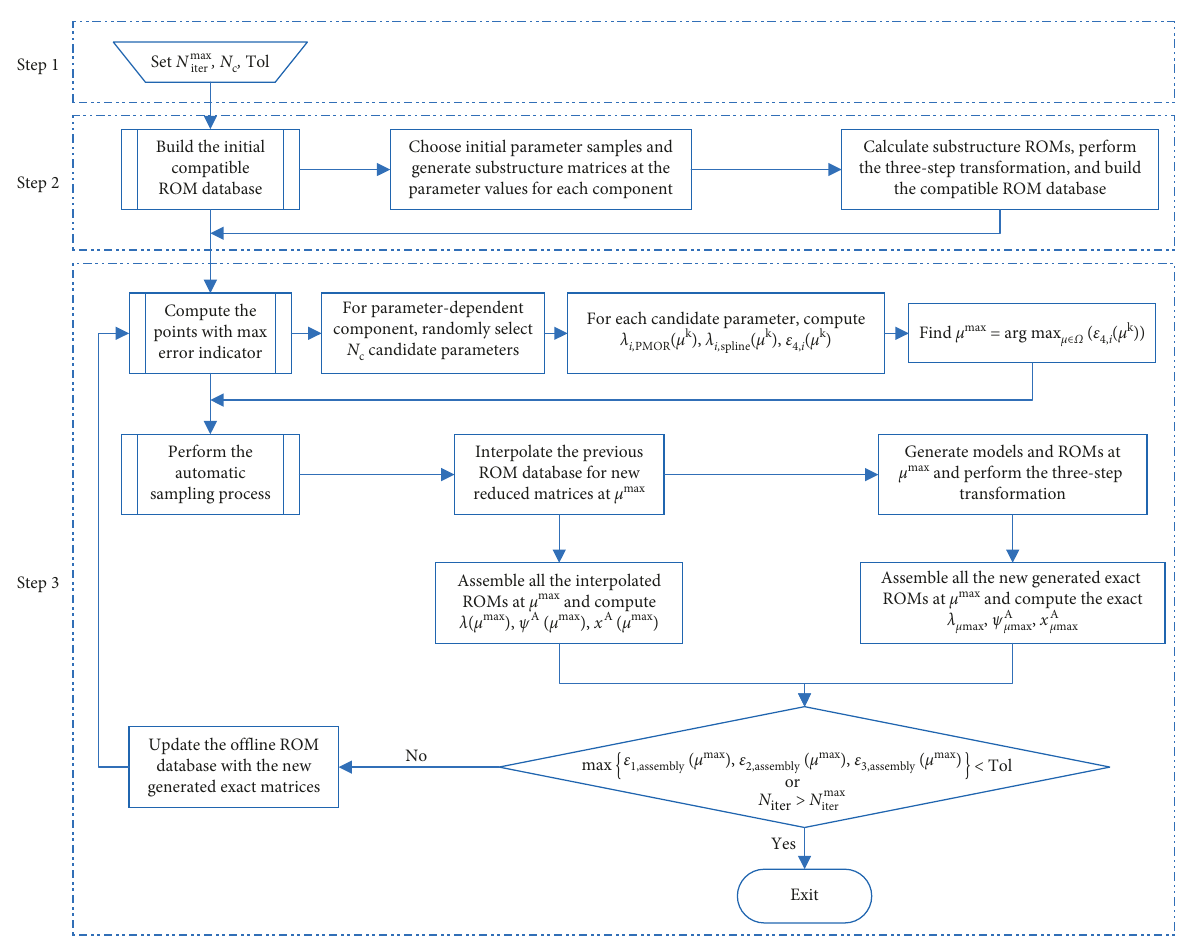
Figure 1: The entire calculation